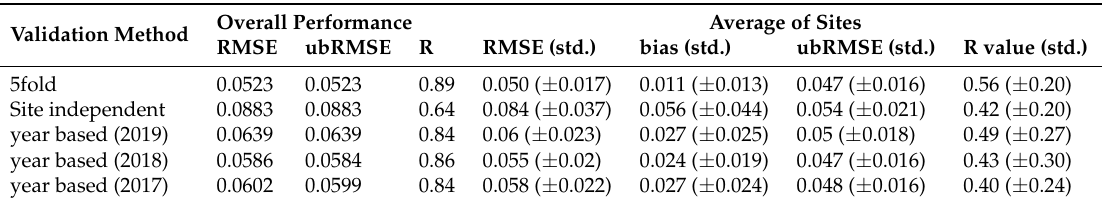
Figure 6. ( a ) The scatter plot of the predicted SM versus in-situ SM through a RF-based model with 8 selected input features and ( b ) the Taylor diagram for all sites . Table 3. Overall and site-averaged performance metrics for different cross-validation methods. Numbers in parentheses are the standard deviation (std.) of metrics across different